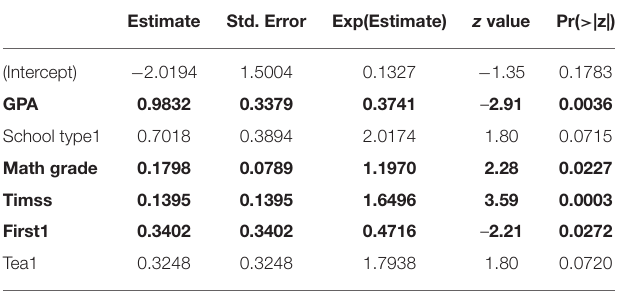
TABLE 2 | Group differences between B.Ed. students (teachers) and B.Sc. students.